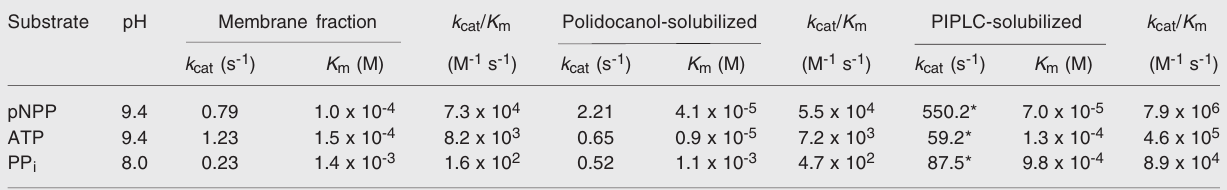
Table 1. Kinetic parameters of tissue-nonspecific alkaline phosphatase present in the matrix vesicles acting on different substrates.